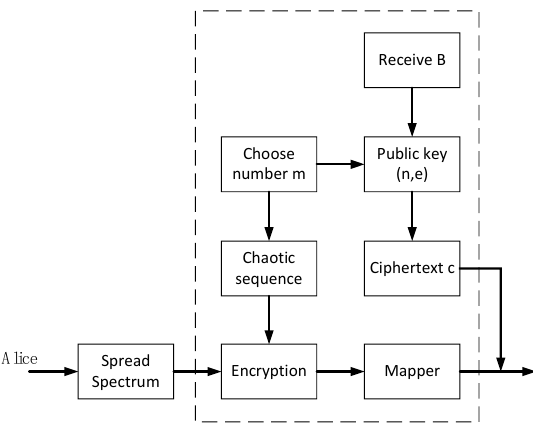
Figure 3. Transmitter encryption block diagram.